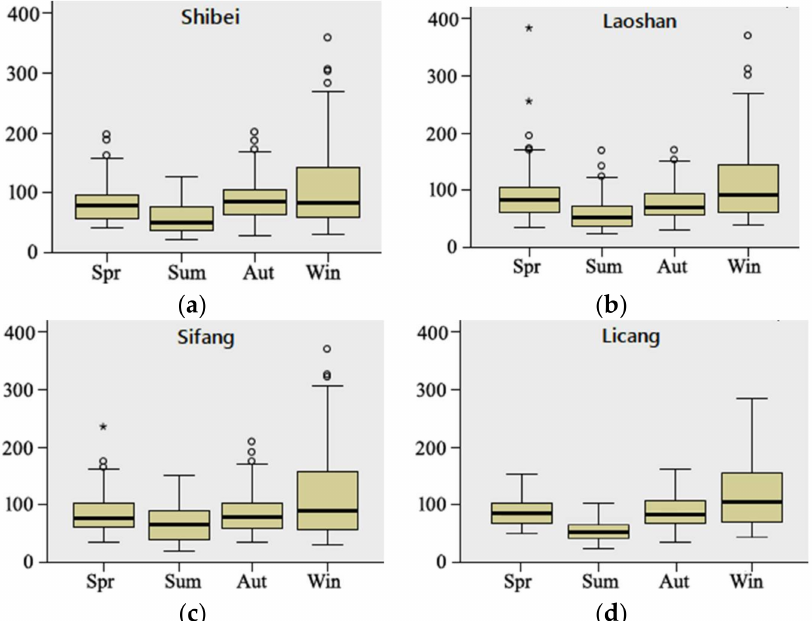
Figure 3. Box-plot of the Kruskal-Wallis rank-sum test for ( a ) Shibei site; ( b ) Laoshan site; ( c ) Sifang; ( d )